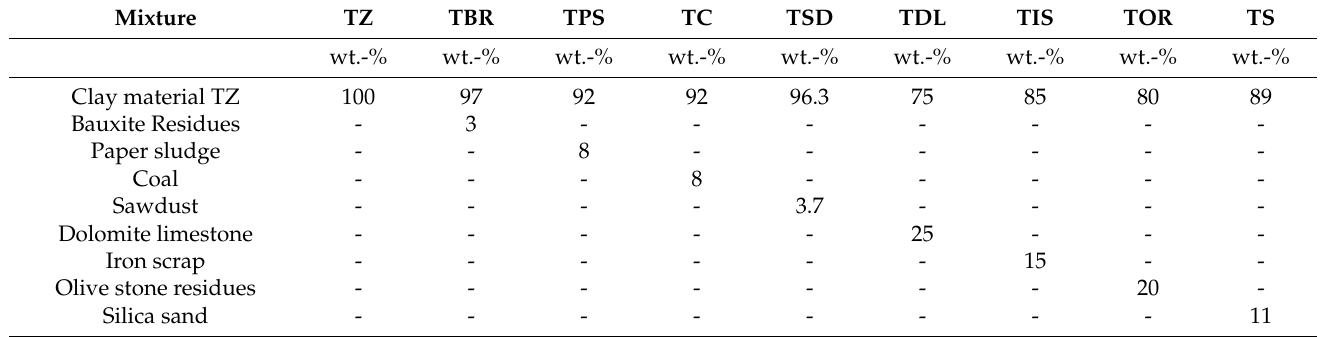
Table 2. The nine (9) labeled constructed mixtures with the ratio of each additive in the mixture.